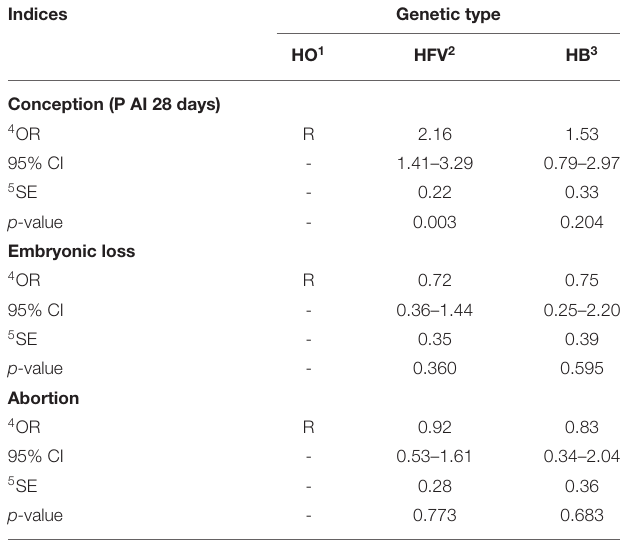
TABLE 2 | Description for reproductive indices and health traits of purebred Holstein, Holstein × Fleckvieh, and their Holstein × Brown Swiss cows. Indices (%)